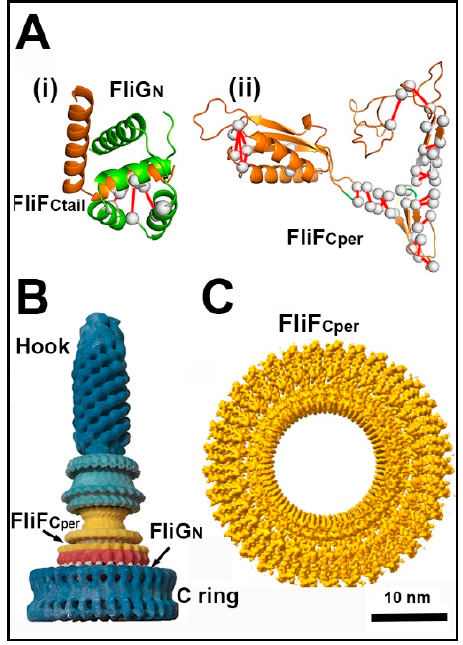
Figure 7. Transmembrane torque transmission. ( A ) ( i ) Conserved FliG N /FliF C-tail coevolved contacts mapped onto the T. maritima crystal structure (PDB: 5tdy [125]). ( ii ) Predicted FliF Cper